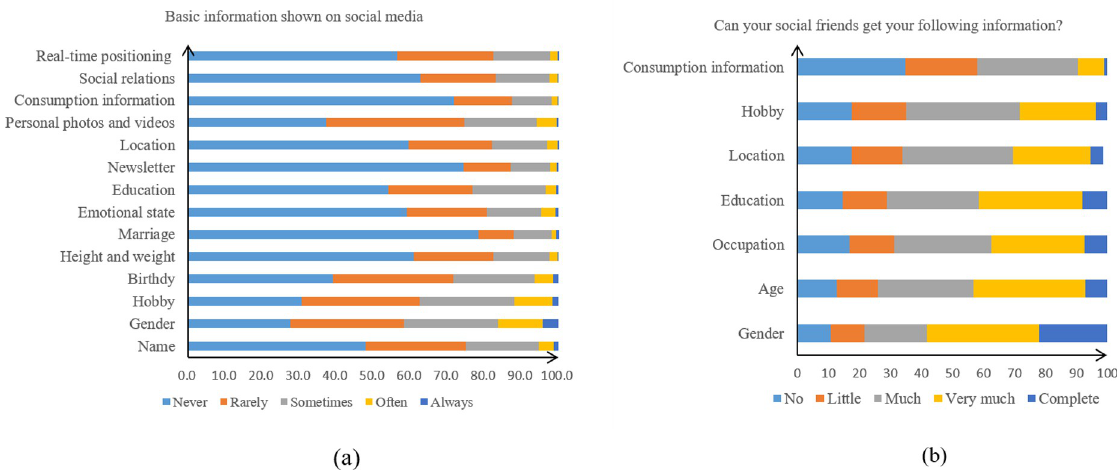
Fig 2. Self-disclosure in social media (n = 1054). a) Basic information shown on social media; b) What information about you can be obtained by your social friends from social media